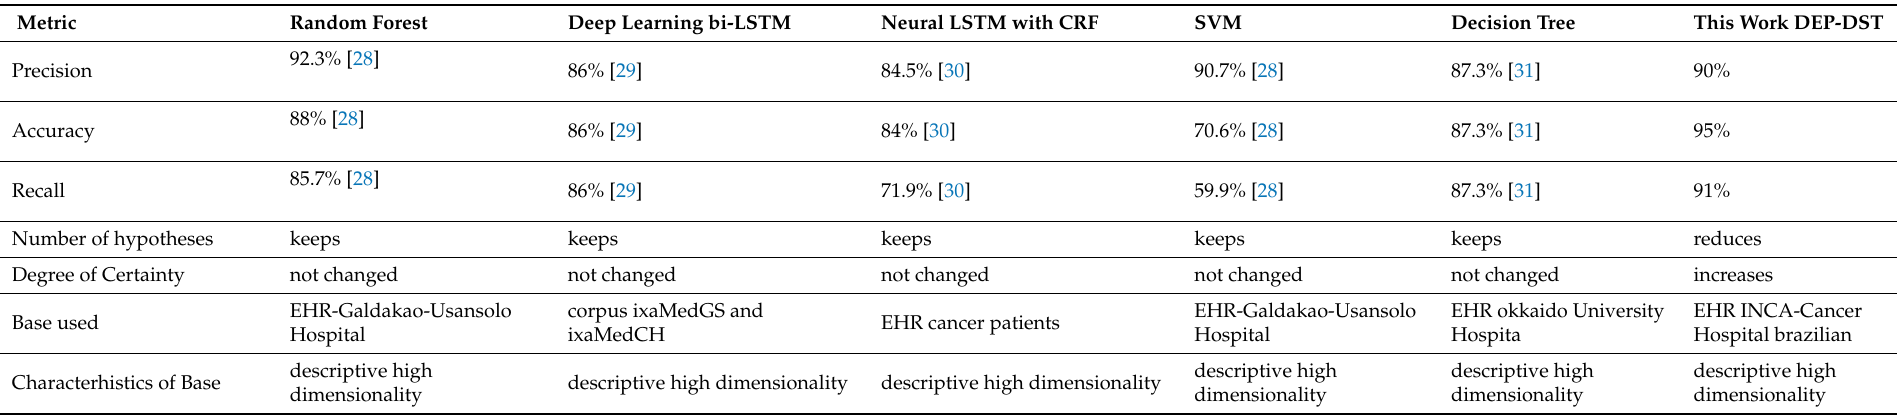
Table 4. Benchmark analysis